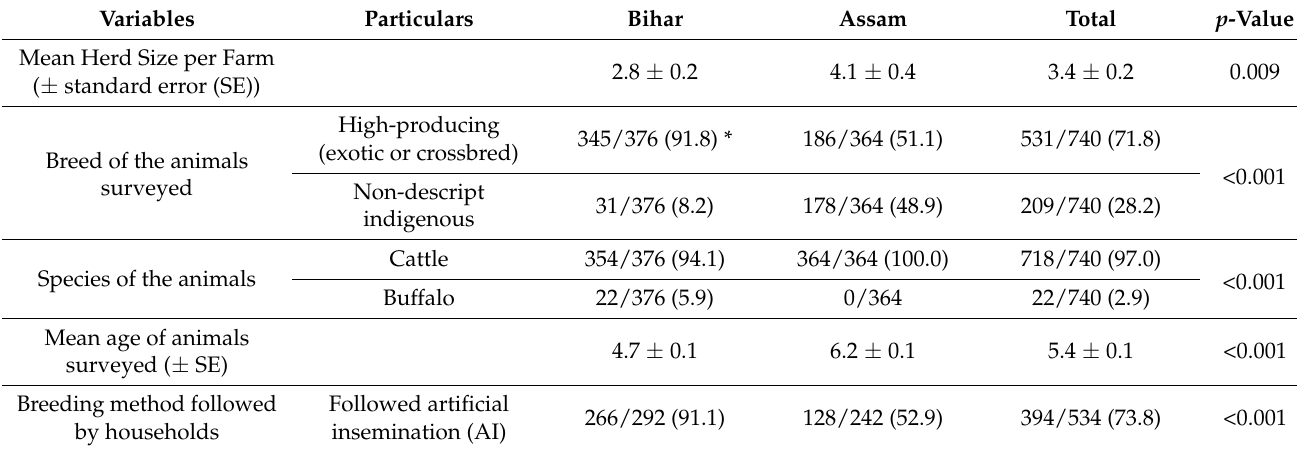
Table 1. Profile of the dairy animals among the surveyed households, with p -values of differences between Bihar and Assam, India. Variables Particulars Mean Herd Size per Farm